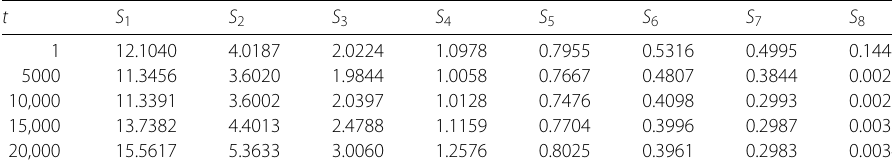
Figure 7 Approximated salinity of simulation 2 at station S 1 by (cid:4) x = 0.1 and (cid:4) t = 0.05 for all 0 ≤ t ≤ 1000